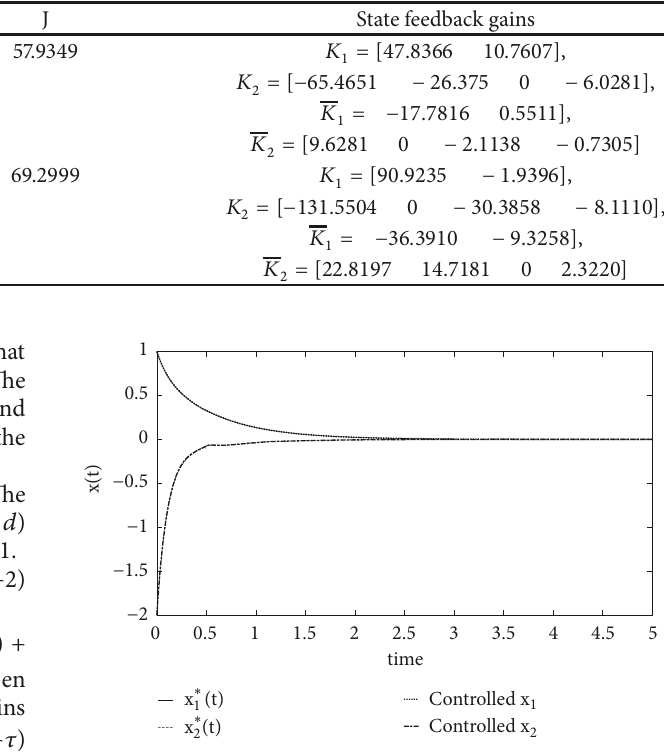
Figure6:Optimalandsuboptimalstatestrajectoriesofthechemical reactor.